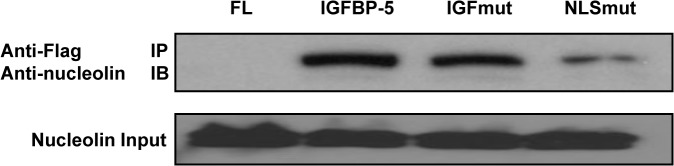
Mutating the NLS domain of IGFBP-5 reduces its ability to bind nucleolin.The interaction of Flag-tagged IGFBP-5 and nucleolin was detected using immunoprecipitation using anti-Flag antibody followed by immunoblotting to detect nucleolin. Input nucleolin was detected in lysates prior to co-precipitation to ensure that samples contained equivalent amounts of protein.